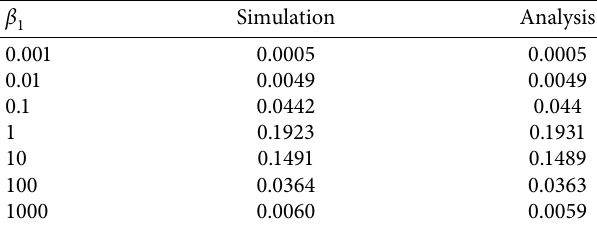
Table 1: Data of instantaneous error versus β